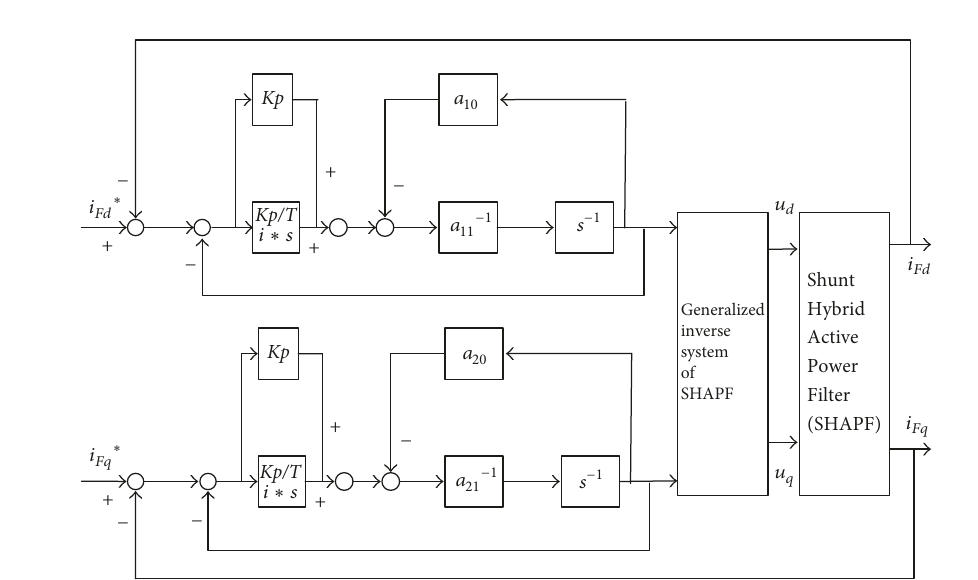
Figure 4: Structure diagram of SHAPF control system.